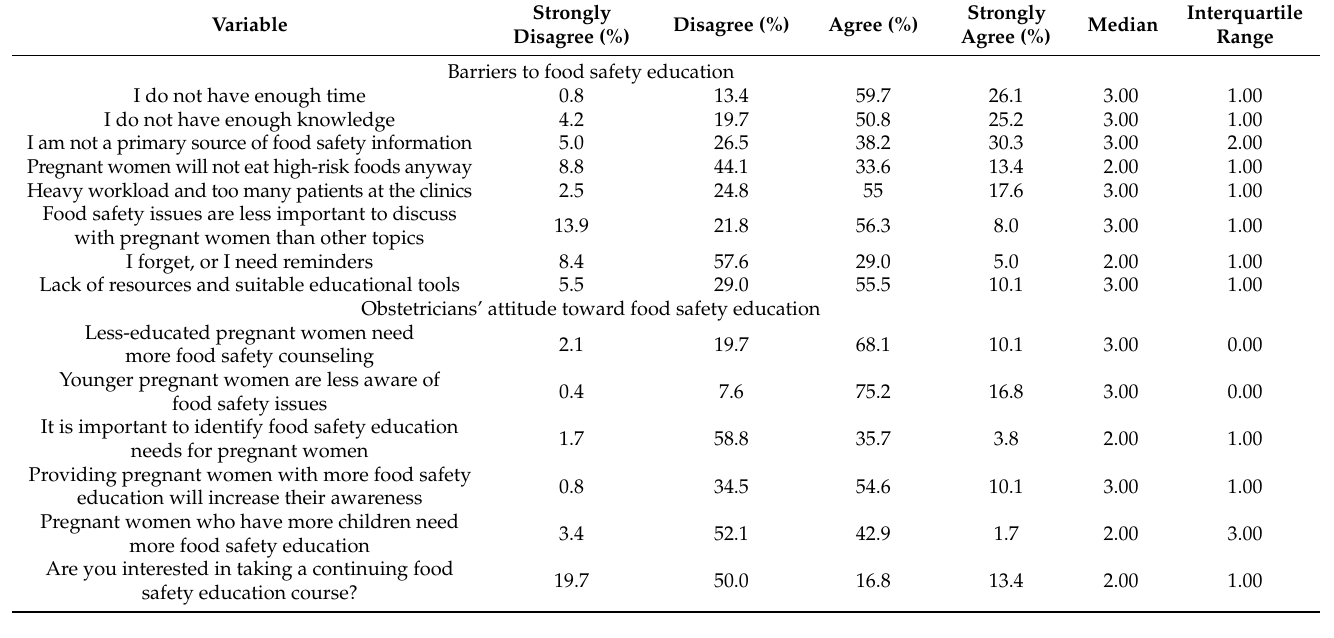
Table 4. Obstetricians’ attitude and barriers regarding food safety education.